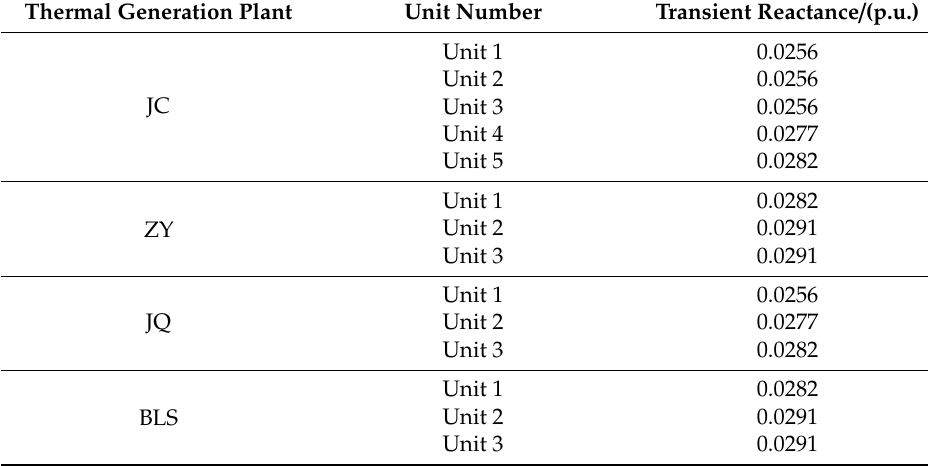
Table A1. Transient parameters of units in each thermal generation plant.